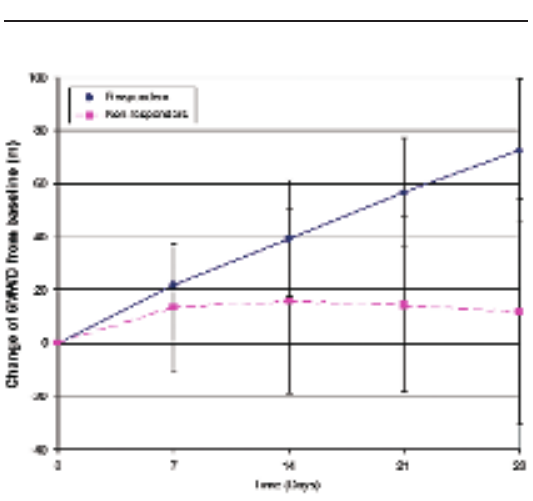
Figure 4 Change of 6-minute walk distance from baseline during oral corticosteroid trial.